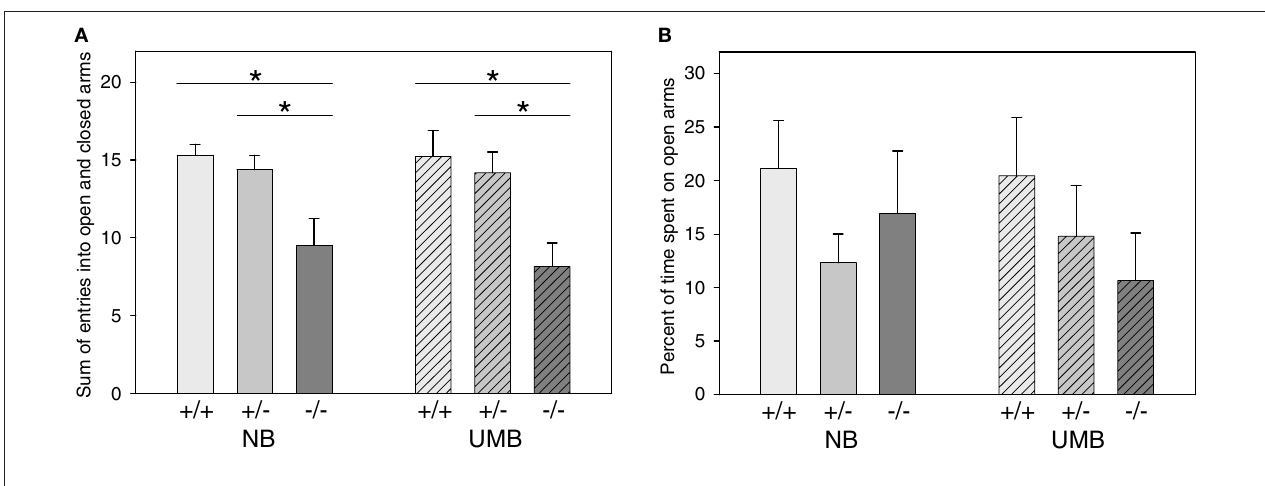
FIGURE 2 | Elevated plus maze test. NB, neutral bedding; UMB, unfamiliar male bedding; + / + , + / − , − / − : 5-HTT genotypes. Data are shown as mean + SEM. Statistics: ANOVA, post hoc testing: Bonferroni corrected t -tests: * P < 0.05. Data were obtained from 36 NB males (6 + / + , 19 + / − , 11 − / − mice), 28 NB